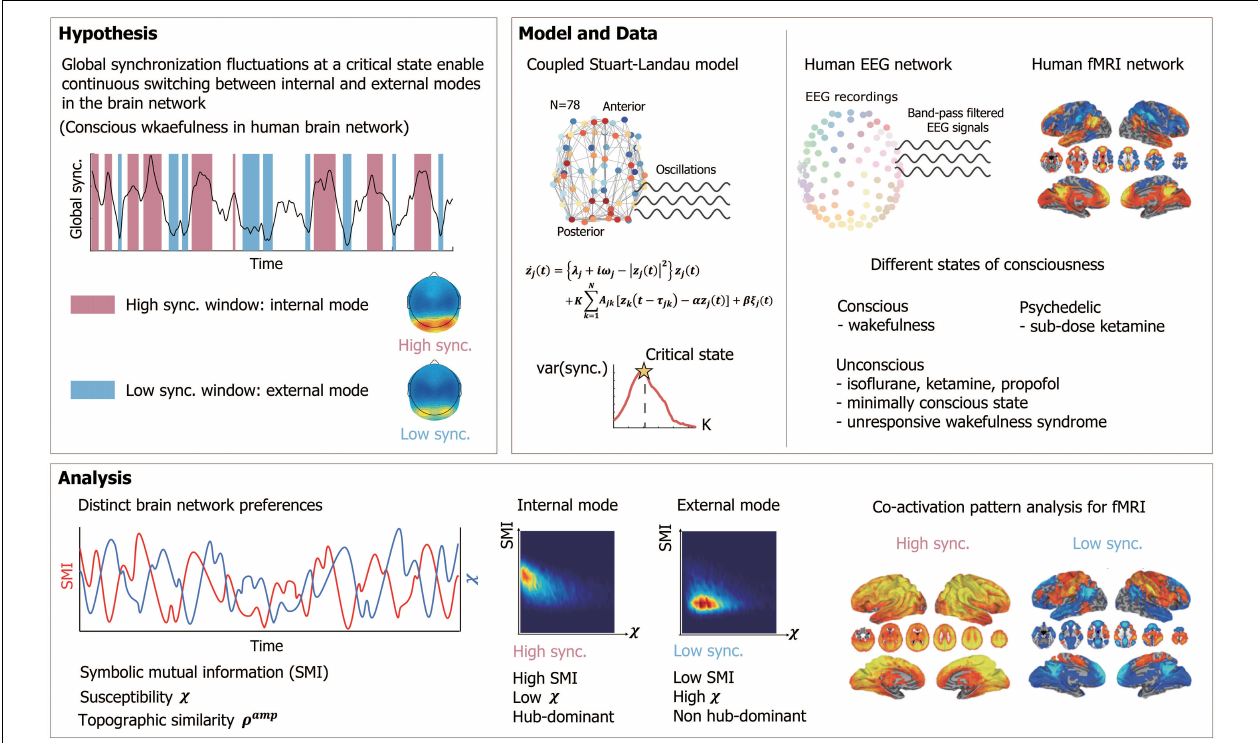
FIGURE 1 | Schematic diagram of study design. We hypothesized that a large global synchronization fluctuation emerging near a critical state enables continuous switching between internal (conducive to integration of internal information) and external (highly susceptible to external stimuli) modes with distinct functional network configurations in a human brain network during conscious wakefulness. The study was composed of two parts, a mathematical modeling and an experimental analysis. We constructed a human brain network model, applying a coupled Stuart-Landau model to a human brain network structure consisting of 78 brain regions. The critical state was found with a maximum variance of the global synchronization. Human electroencephalogram (EEG) data were acquired in different states of consciousness including conscious states (CS), psychedelic state induced by sub-dose of ketamine, unconscious states (UCS) induced by isoflurane and ketamine, minimally conscious state (MCS) and unresponsive wakefulness syndrome (UWS). Functional magnetic resonance imaging (fMRI) data were acquired during CS, UCS induced by propofol and UWS. With the model and EEGs, we measured symbolic mutual information (SMI) and susceptibility χ in a sub-second time window to investigate the brain network’s preference for internal and external mode. The topographic similarity S amp was measured to observe functional network configurations for each high and low synchronization window. The co-activation pattern analysis was performed for the fMRI data to obtain fMRI networks related to internal and external